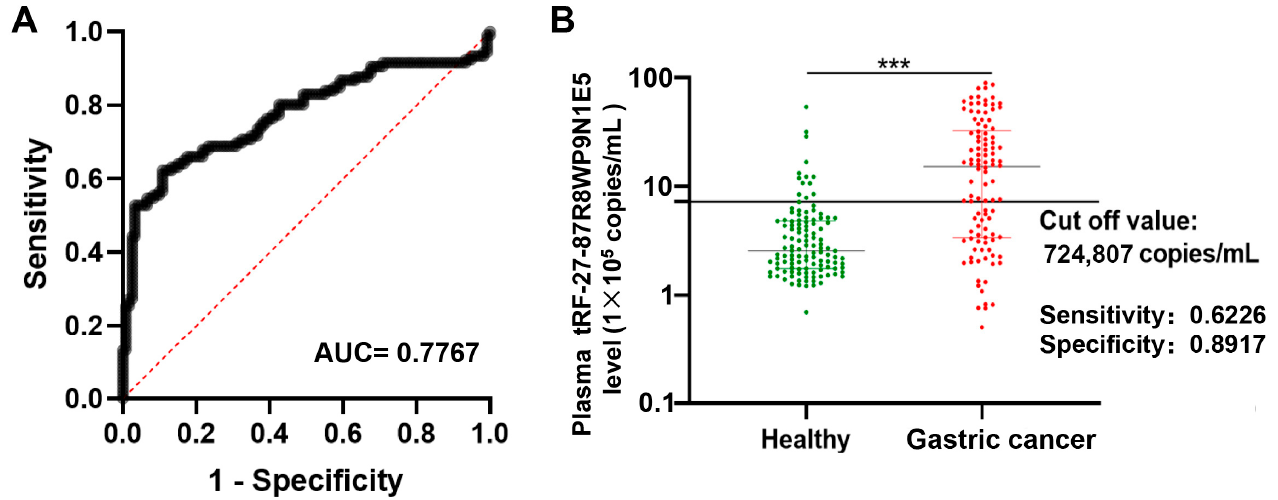
Figure 6. Diagnostic value of tRF-27 in gastric cancer. ( A ) ROC curve of tRF-27 in gastric cancer. ( B ) Cutoff value of tRF-27 in gastric cancer patients was 724,807 copies/mL. Healthy individuals ( n = 120); Gastric cancer ( n = 106). *** p < 0.001.